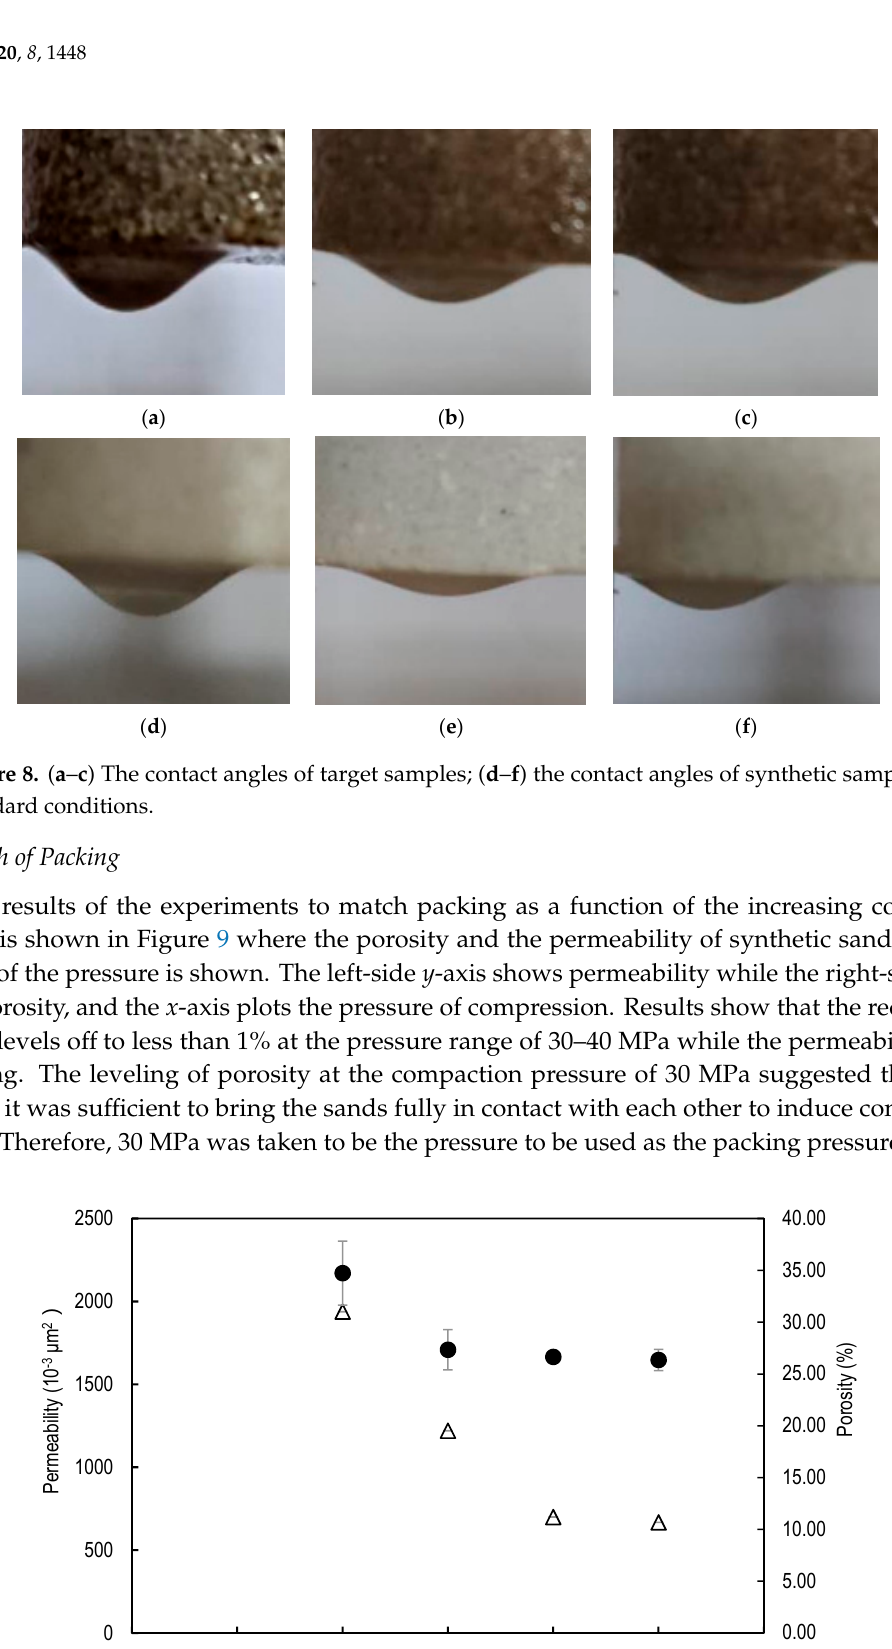
Figure 10. Porosity vs. 2000 mesh sand ratio for rough adjustment of cementation in synthetic sandstone samples. 3.7. The Match of Permeability: Fine Adjustment Phase of Cementation Level At the end of the rough adjustment phase of the cementation level, the sample with porosity within 2% error of the target was also tested for permeability by helium porosimetry to see if the